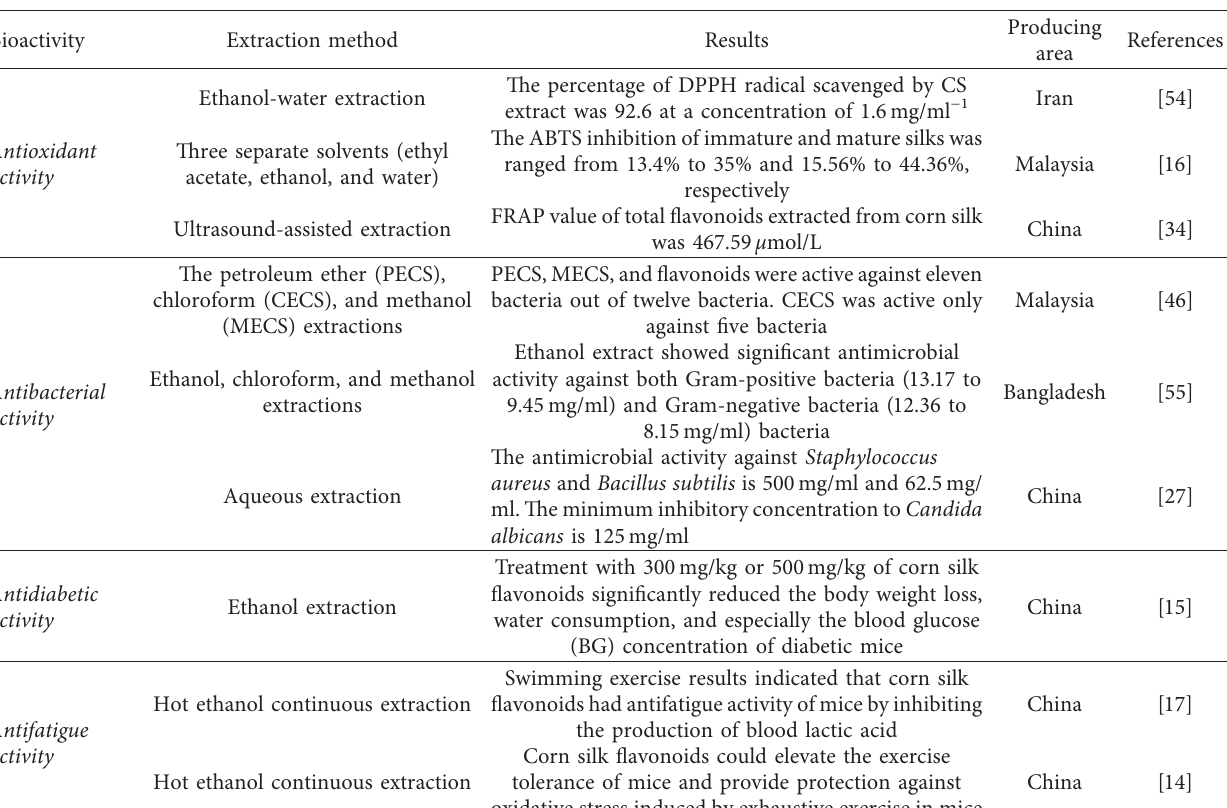
Table 3: Bioactivity and extraction method of flavonoids or flavone glycosides from corn